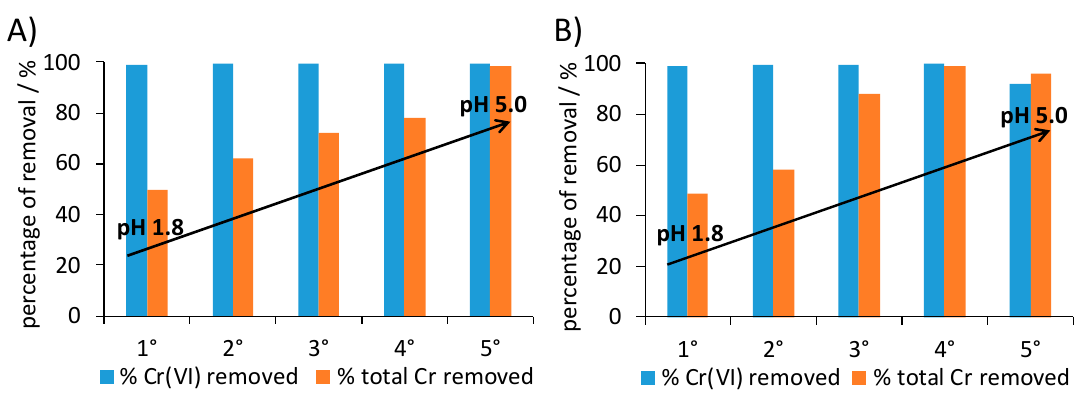
Figure 9. Consecutive chromium removal tests for 1 × 1 nanocomposite: ( A ) 10 ppm and ( B ) 50 ppm initial Cr(VI) concentration. For each test, the removal of Cr(VI) (± 0.04%) and of total chromium (± 4%) are reported.